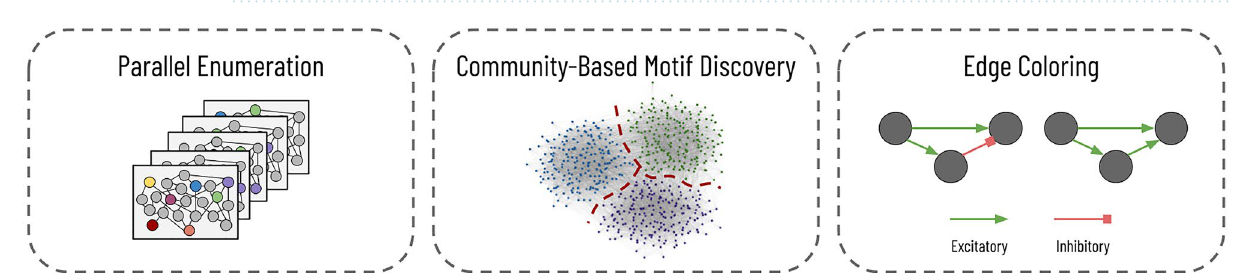
Figure 1. Motifs in the wiring diagram. ( A ) These four subgraphs that appear in the connectome have specific biological functions. Although the biological significance of these motifs was previously hypothesized, enumerating all subgraphs can identify additional essential motifs. ( B ) Here, we see six isomorphic subgraphs of size 3. The node colors do not represent labels but rather correspond to the bijection that preserves edges. The boxed subgraph is the canonical form where the string (bottom right) corresponding to the adjacency matrix (bottom left) is minimized.